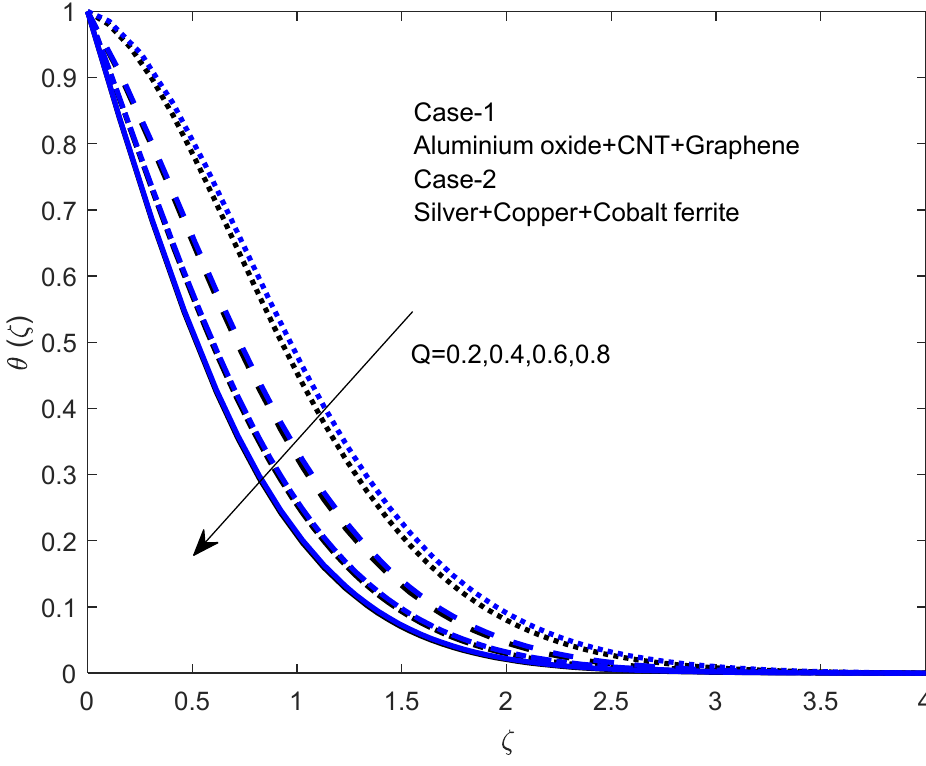
Figure 10. The effect of Q on the temperature profile. Table 1. Thermophysical properties of a hybrid